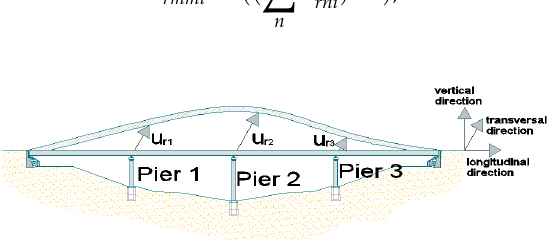
Figure 1. IMPA procedure. ( a ) Evaluation of the performance points (P.P.) for each capacity curve that belongs to the pushover analysis: proportional to Mode 1. Mode n . ( b ) Evaluation of the P.P. for each capacity curve: e.g., via C.S.M. ( c ) Capacity curve plotted in the u r -intensity plane (u r is the displacement of the monitoring point along the investigated direction, e.g., the transverse direction).